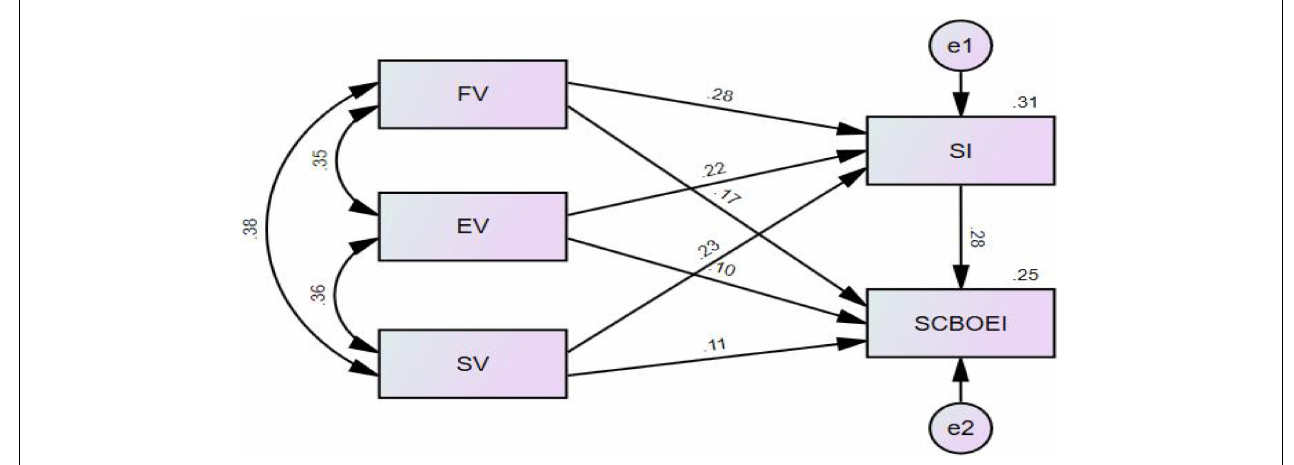
FIGURE 4 | Standardized estimated path coefficient.